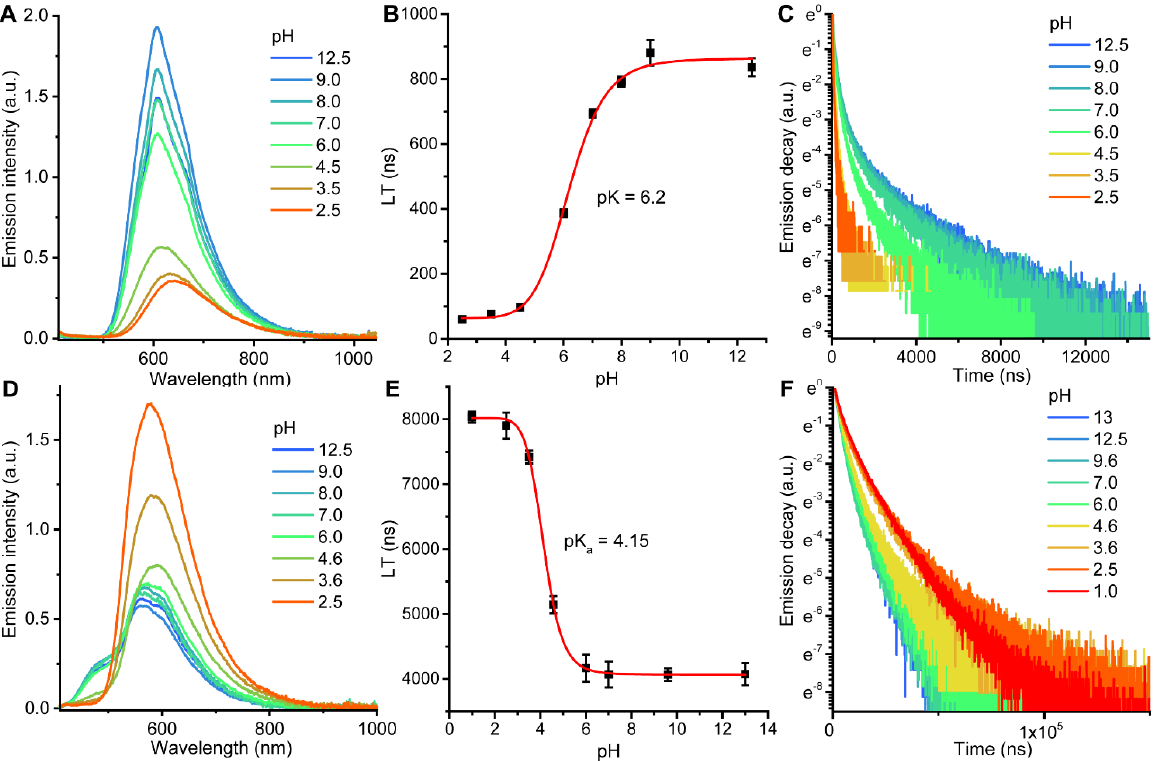
Figure 7. Dependence of emission intensity ( A , D ), lifetime of the excited state ( B , E ), and normalized emission decay curves ( C , F ) of 3 ( A – C , λ ex = 355 nm, λ em = 600 nm) and 4 ( D – F , λ ex = 355 nm, λ em = 560 nm) upon pH variations in aerated aqueous buffer solution (pH 12.5, 8.0, 7.0, 6.0, 2.5 – phosphate buffer solution, pH 4.75, 4.5, and 3.5 – citrate buffer solution, pH 9.0 and 9.6 – borate buffer solution, for 3 buffer/acetone 9/1; v/v ), 293K. Lifetime (LT) of the probes were calculated from bi- (for 4 ) and tri- (for 3 ) exponential decay fit as intensity-weighted average lifetime ( τ av , see Equation (1)).